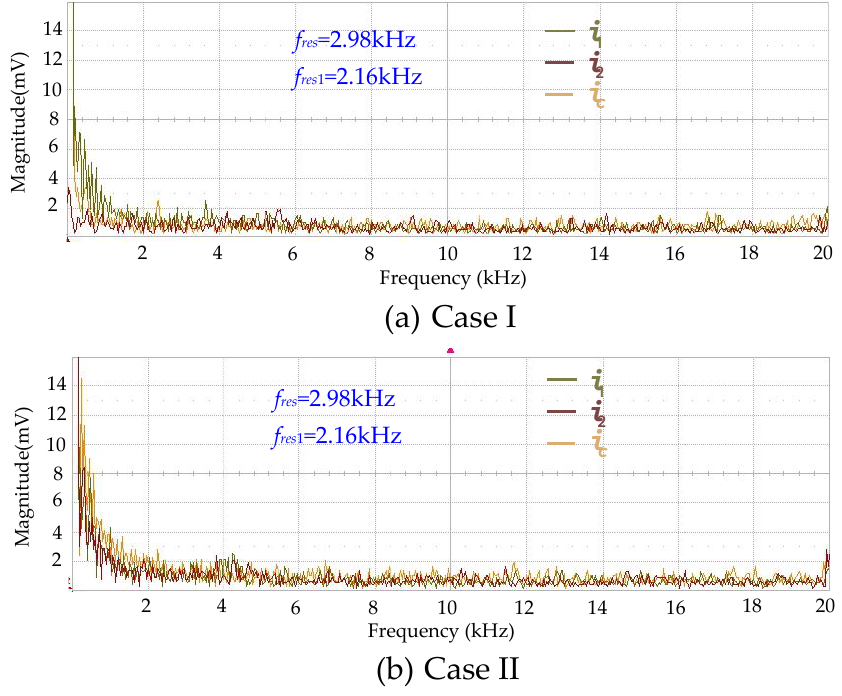
Figure 14. Harmonic analysis under the proposed scheme.